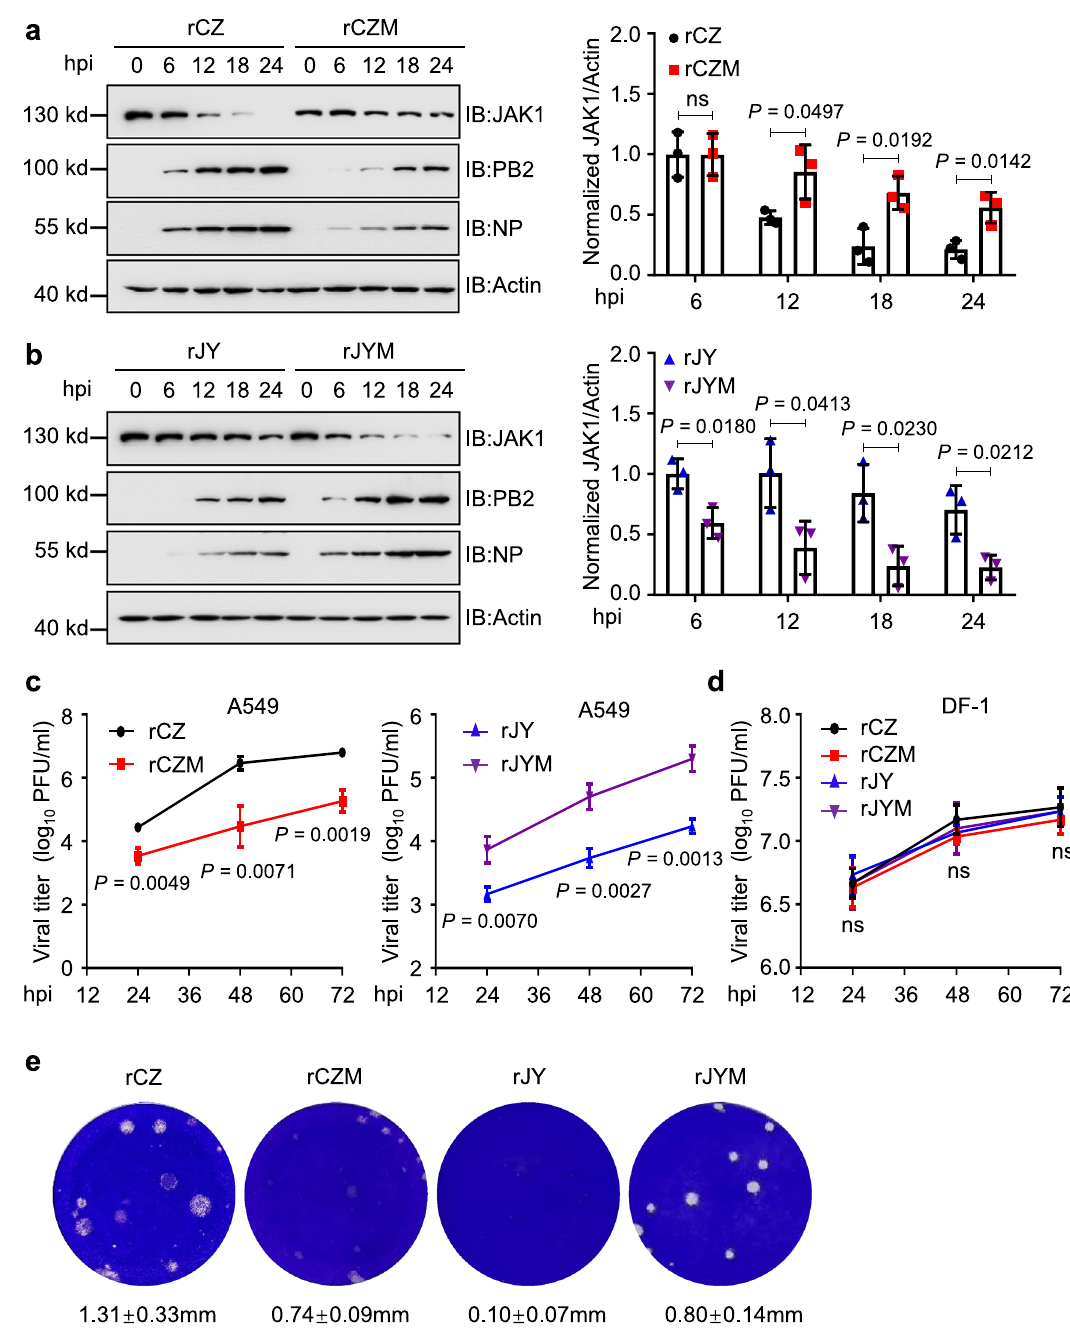
Fig. 9 | JAK1 degradation mediated by AIV PB2 affects virus replication in mammaliancells. a , b Immunoblots ofA549cells infected with rCZ, rCZM, rJY, or rJYM virus (left). The intensities of the bands on the immunoblots from three independent experiments were quanti fi ed and normalized with actin (right). c , d Growth curve of viruses in A549 ( c ) or DF-1 cells ( d ) infected with rCZ, rCZM,